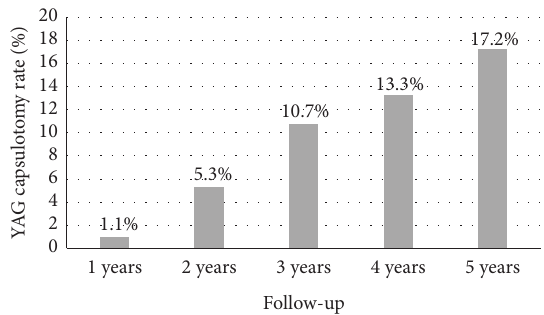
Figure 1: Changes in YAG capsulotomy rate during the follow-up in the sample of eyes